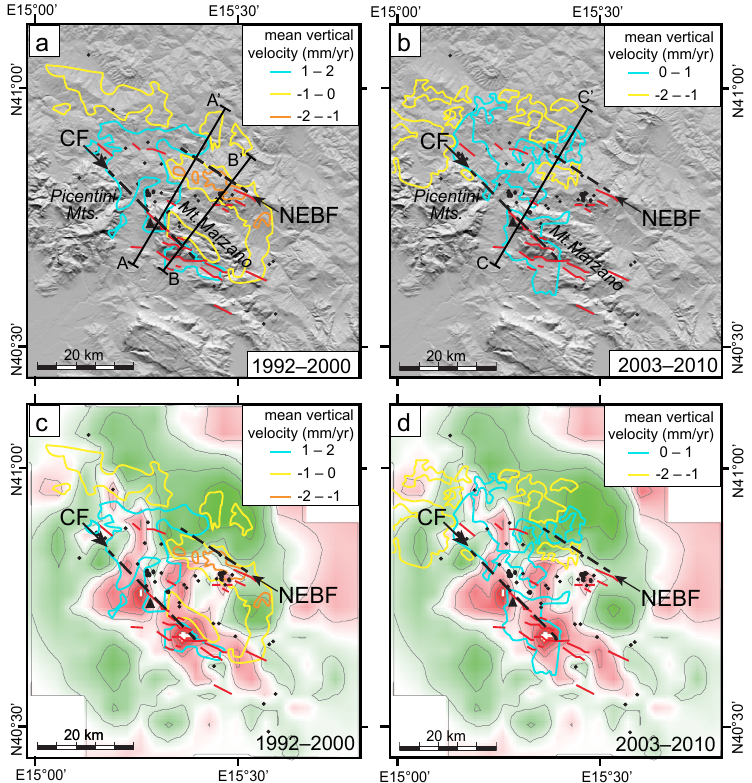
Figure 12. Multitemporal ground deformation patterns plotted against the pattern of active faults at the surface (red segments, from Ascione et al. [7]) and the projections at the surface of the deep-seated CF and NEBF (dashed black lines, from Amoroso et al. [8]; see Figure 2), which correspond to the structures activated with the 1980 Irpinia earthquake at 0 s and 40 s, respectively. The ground deformation patterns result from analyses of the ERS and ENVISAT datasets selected by the Cluster and Outlier Analysis . ( a , c ) Ground deformation in the 1992–2000 timespan. ( b , d ) Ground deformation in the 2003–2010 timespan. The map in the background of diagrams ( c , d ) corresponds to the spatial distribution of the V P / V S ratio in a horizontal slice at 6 km depth through the P-wave tomographic model, with micro-earthquakes (black dots) recorded from 2005 to 2011, as in Figure 7 (from Amoroso et al. [8], modified). Traces of ground deformation profiles of Figure 13 are also shown in diagrams ( a , b